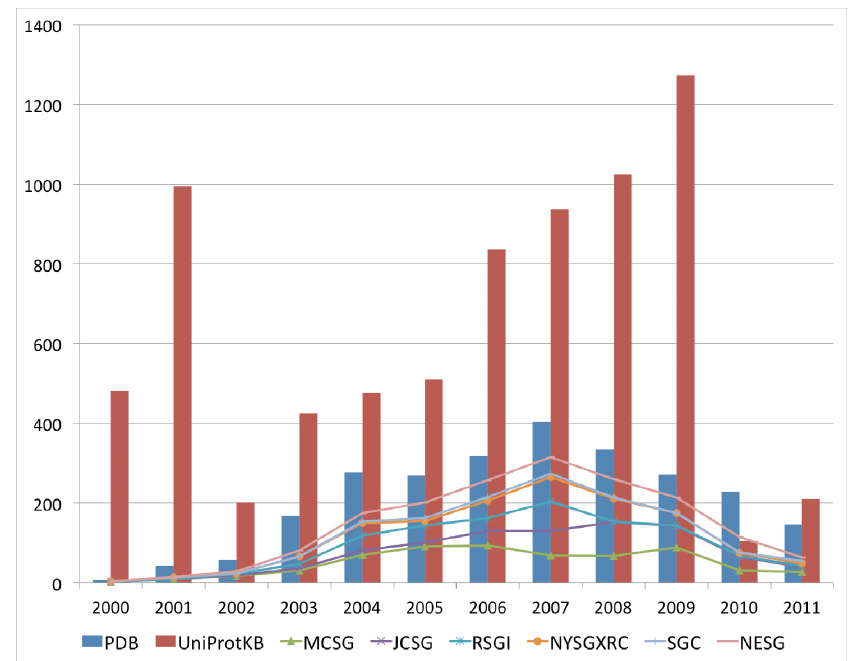
Figure 1. The bars show the trend of uncharacterized protein sequence (in UniProtKB) and structure (in the Protein Data Bank (PDB)) determination from 2000 to 2011. The stacked lines show uncharacterized protein structures in the PDB solved by the top six Structural Genomics Centers from 2001 to 2011, in comparison with structures solved by other laboratories or institutions. The top six centers are RIKEN Structural Genomics/Proteomics Initiative (RSGI), Midwest Center for Structural Genomics (MCSG), Joint Center for Structural Genomics (JCSG), Structural Genomics Consortium (SGC), New York Research Center for Structural Genomics (NYSGXRC), and Northeast Structural Genomics Consortium